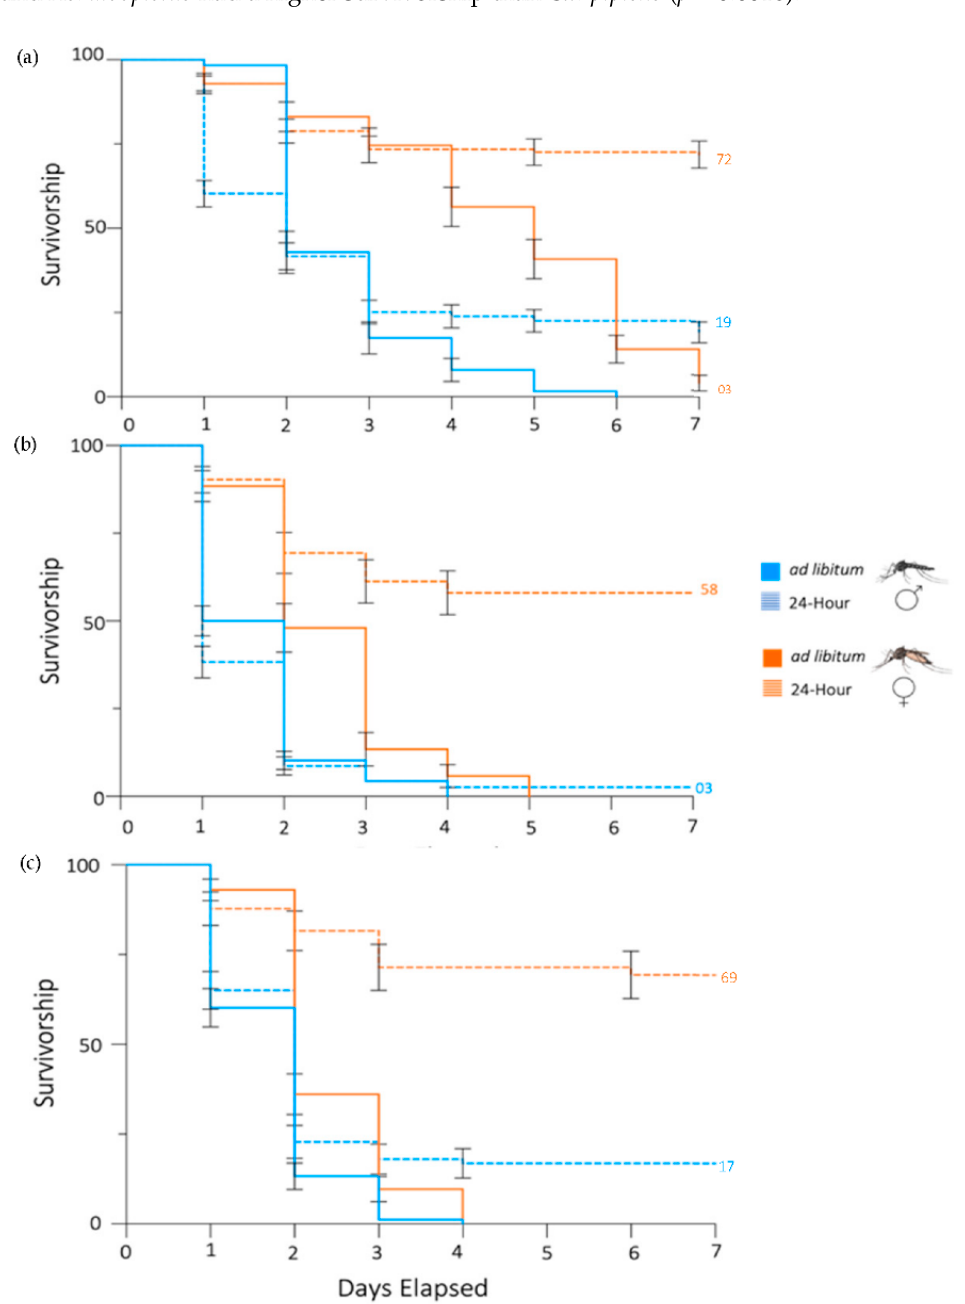
Figure 2. Propylene glycol reduces the daily survivorship of male and female Ae. aegypti mosquitoes. A Kaplan–Meier curve demonstrates the decline in mosquito survivorship over the course of 7 days: ( a ) 5% sucrose + 5% propylene glycol, ( b ) 5% sucrose + 7.5% propylene glycol, or ( c ) 5% sucrose + 10% propylene glycol ad libitum or for a 24 h period, at which point the propylene glycol solutions were replaced with 5% sucrose. Percentage of the population surviving at day 7 is provided when applicable. Error bars indicate SE of the